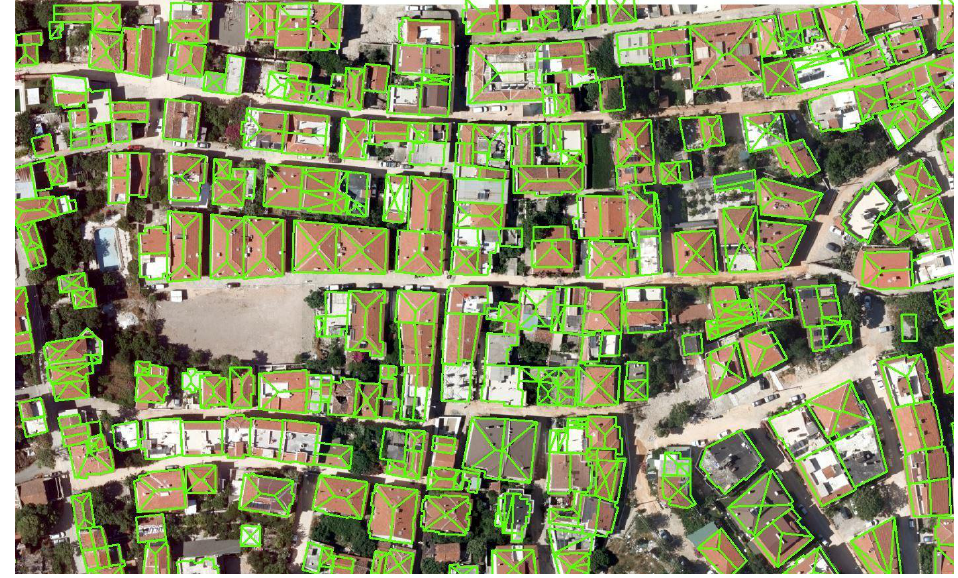
Figure 15. Automatically generated roof geometries overlaid on the orthophoto with 10 cm resolution. Table 2. Automatic building reconstruction accuracy based on visual analysis of 1000 buildings.